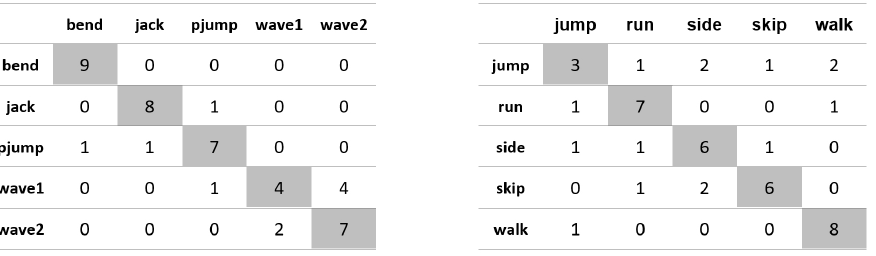
Figure A9. Confusion matrices for the experiment using the ‘lower-occlusion’ database, MBR perimeter and Euclidean